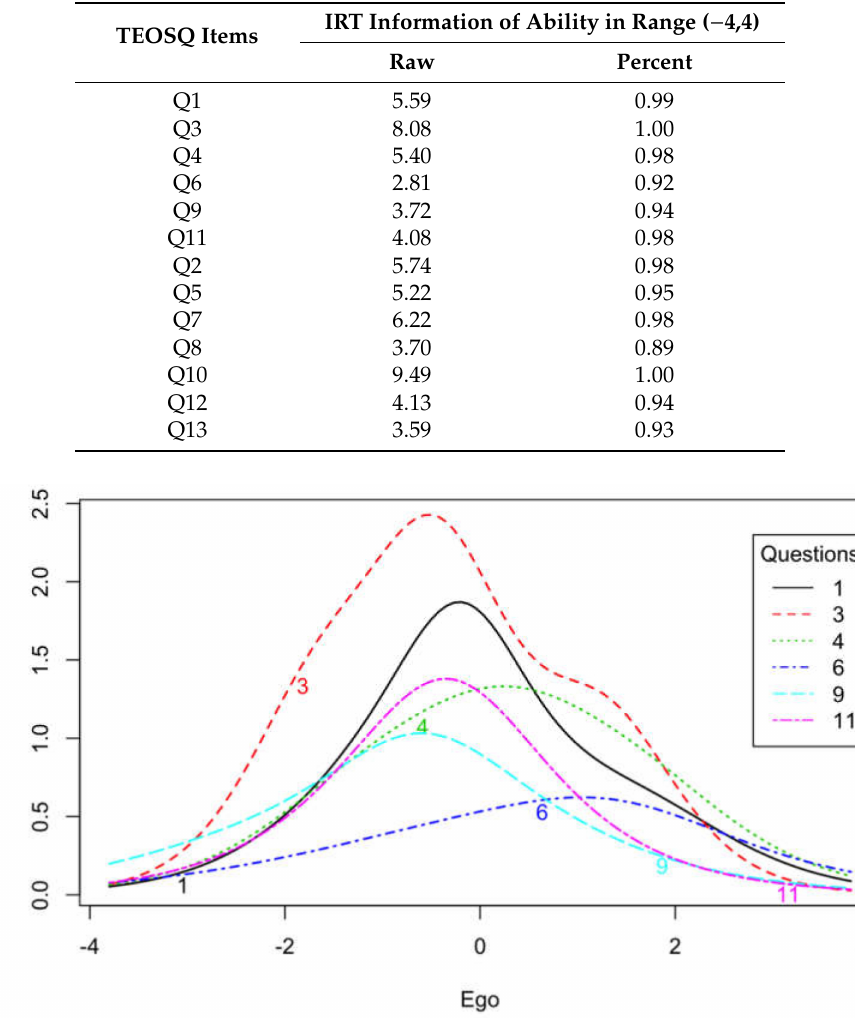
Table 1. Informative function for TEOSQ items.